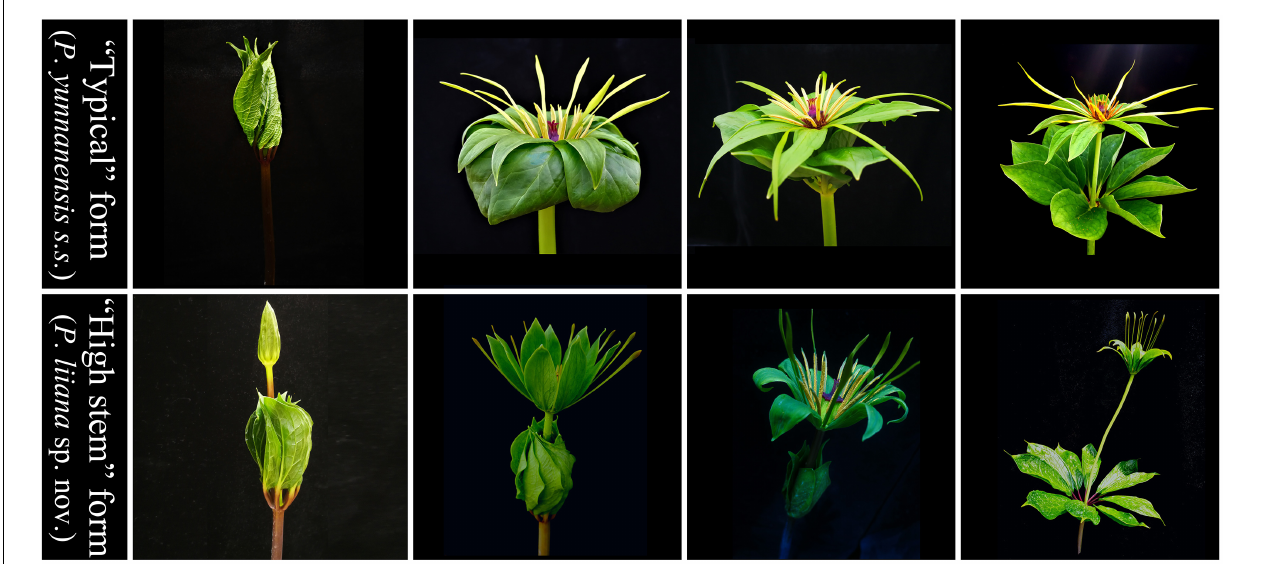
FIGURE 5 | Comparison of the development of aerial shoot between “typical” Paris yunnanensis ( P. yunnanensis s.s. ) and “high stem” form ( P. liiana sp. nov.).